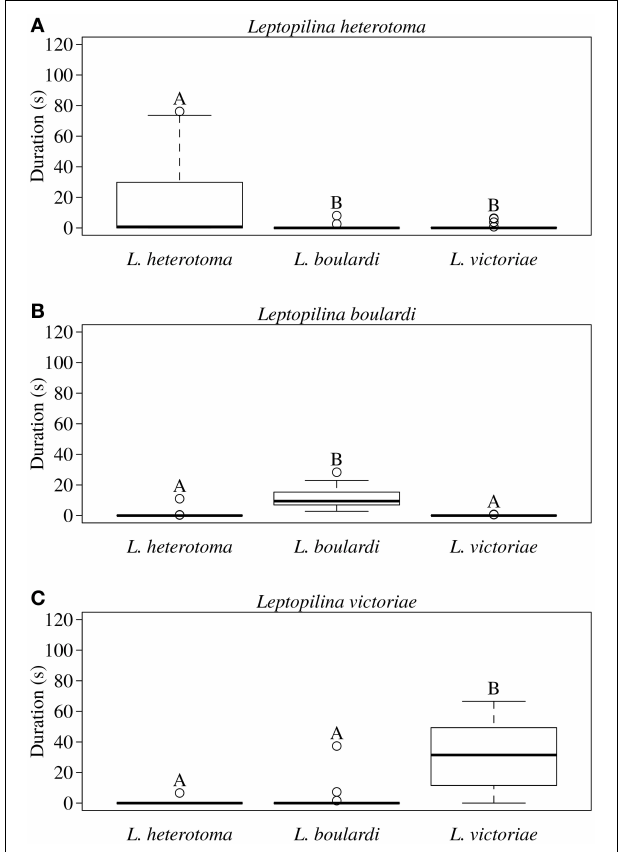
FIGURE 1 | Total duration of wing fanning displayed by males of (A) L. heterotoma , (B) L. boulardi , and (C) L. victoriae toward con- and heterospecific females ( n = 20 ). Different letters indicate significant differences between median values at p < 0 . 05 ( Mann-Whitney U -test with Bonferroni-Holm correction); comparisons were only made within but not between male